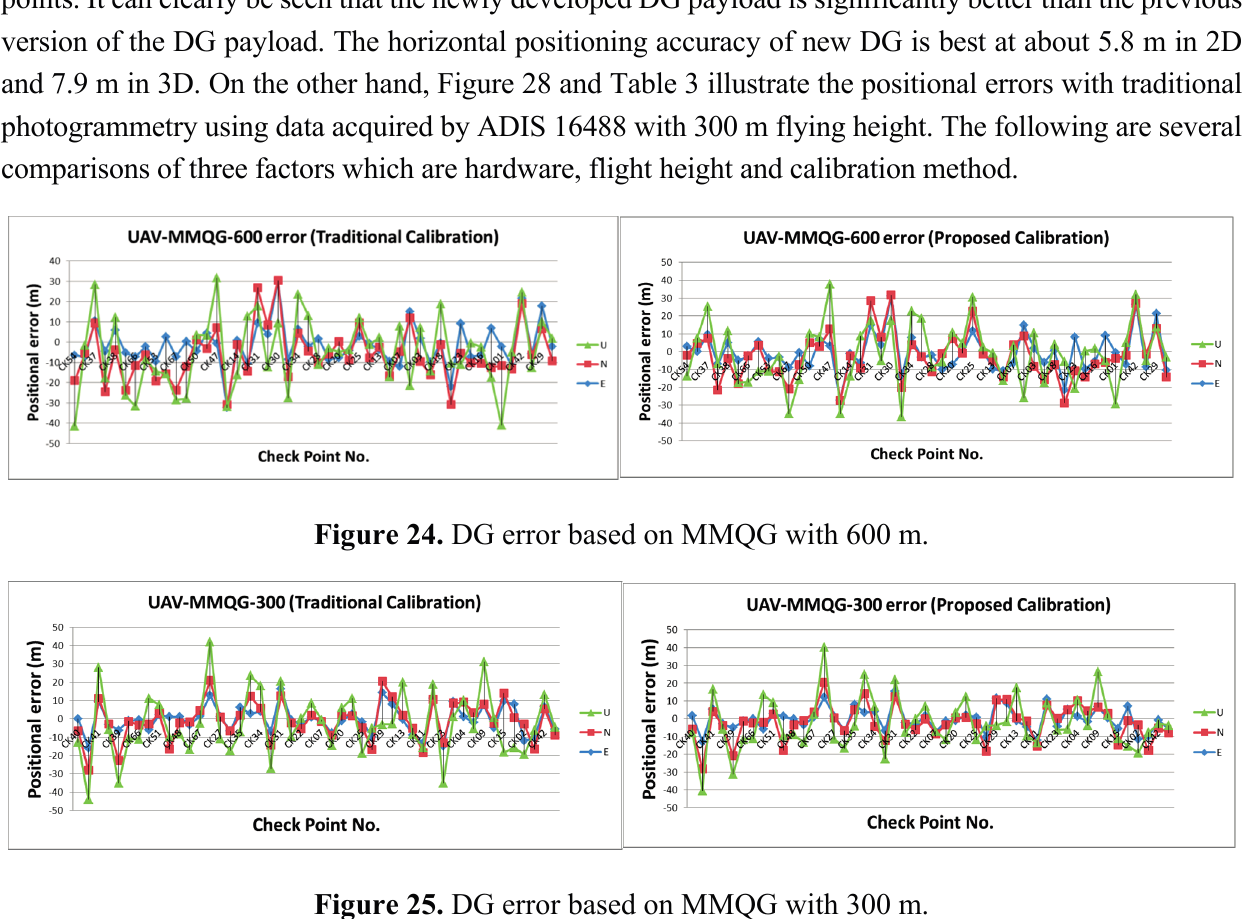
Figure 25. DG error based on MMQG with 300 m.